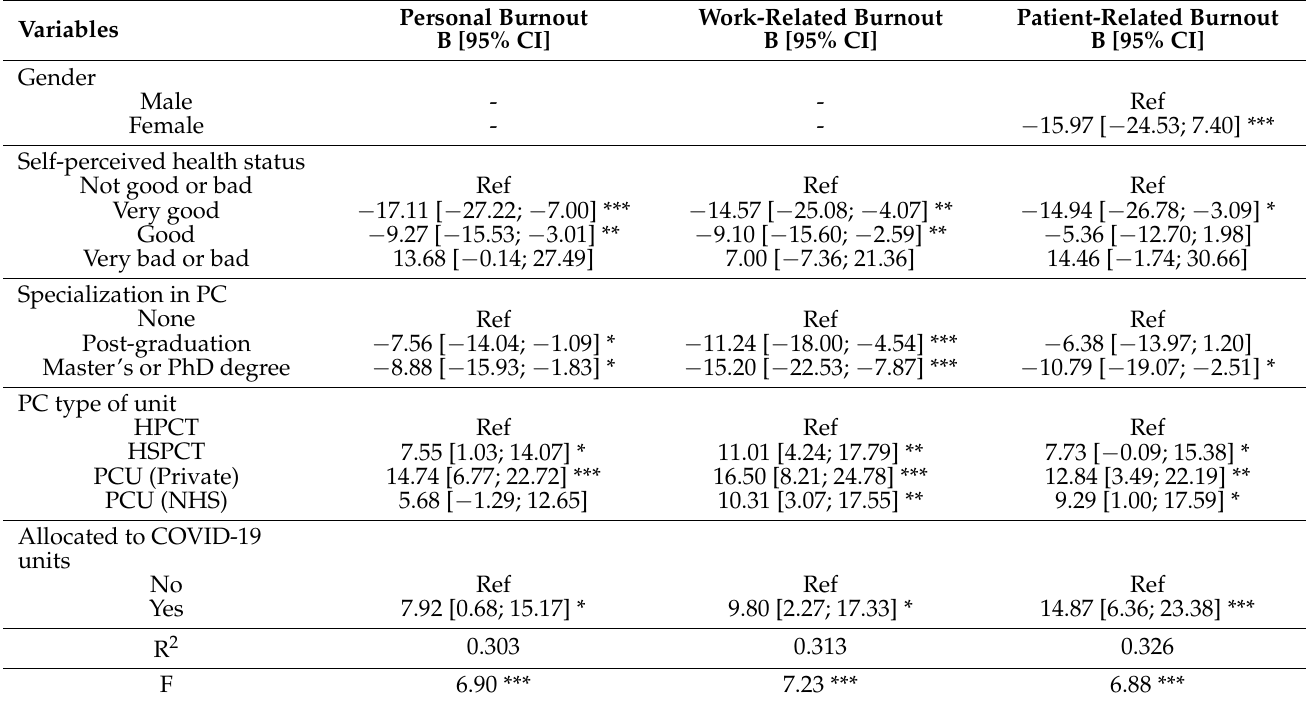
Table 3. Unstandardized regression coefficients of multivariable models for the subscales of burnout according to CBI as outcomes and personal, work and COVID-19 variables as